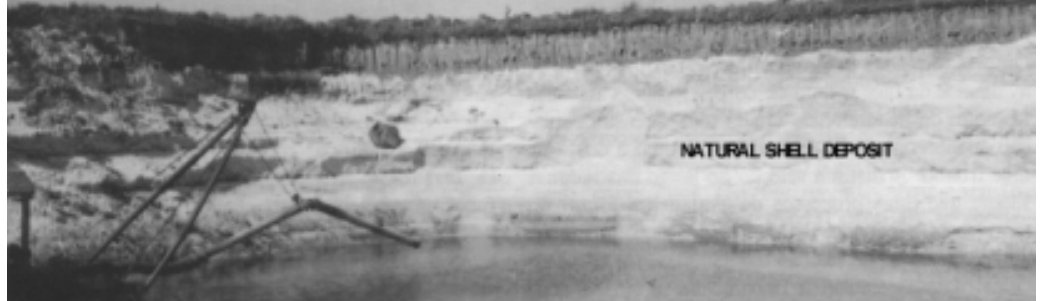
An. Acad. Bras. Ci. ,(2000) 72